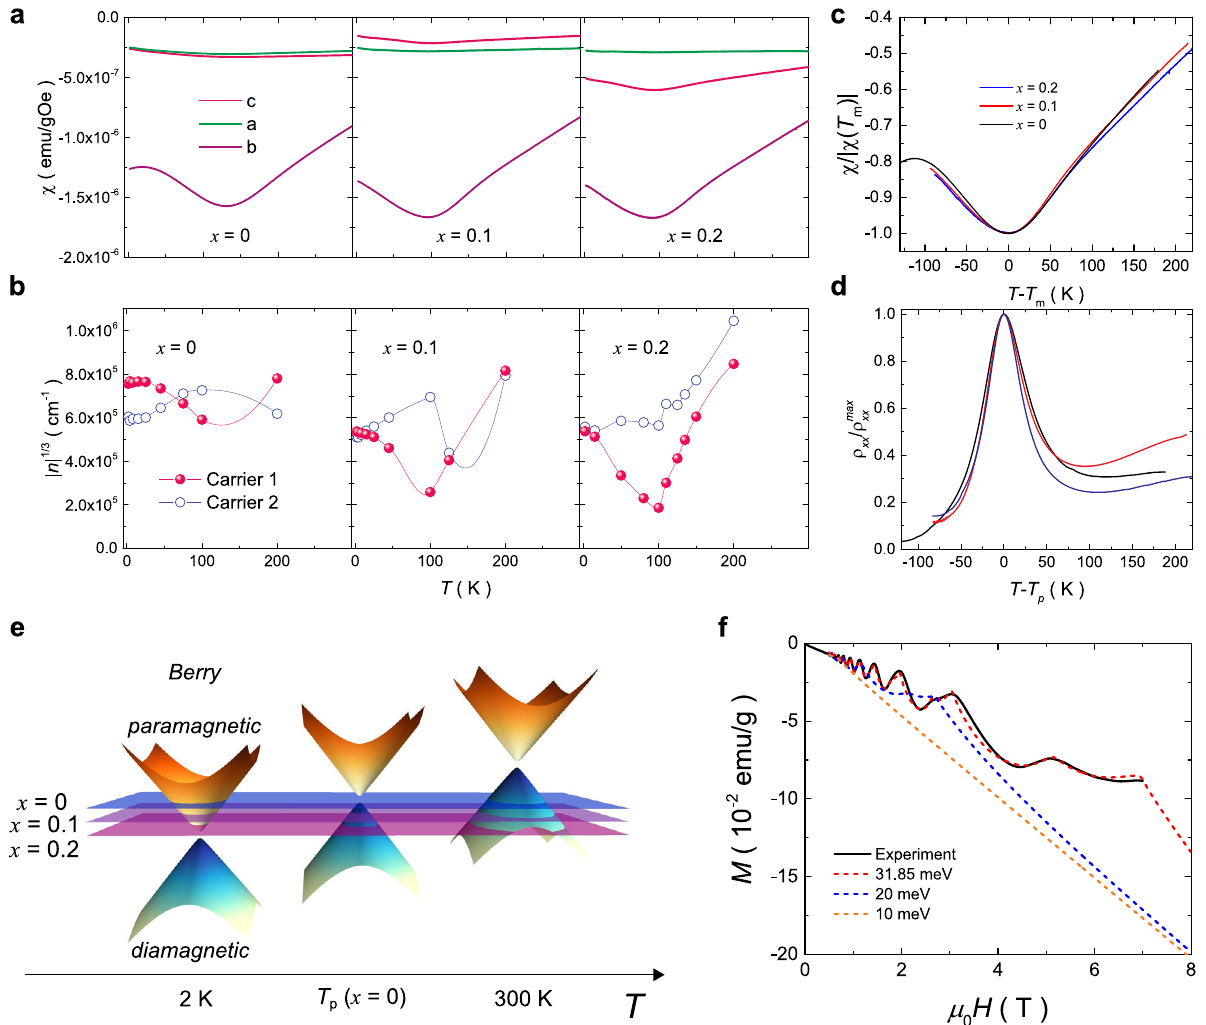
Fig. 5 Correlation between resistivity and susceptibility. a Temperature dependence of susceptibilities with 7 T of a magnetic fi eld along with a , b , and c axes. b Temperature dependence of j n j 1 = 3 of carriers 1 and 2. The values of n were extracted from the two-carrier analyses. The error bars obtained using the standard error of the two-carrier fi t to a power of 1/3 are smaller than the size of the data symbols. c Normalized susceptibility curves. The susceptibilities were divided by the maximum value and plotted as a function of the relative temperature, T − T m , where T m is the temperature at which the susceptibility shows its minimum. d Normalized resistivity curves. The resistivities were divided by the maximum value and plotted as a function of the relative temperature, T − T p , where T p is the temperature at which the resistivity shows its peak. e Schematic picture for magnetic susceptibility and band shift depending on temperature for three samples. The planes show the Fermi energy of each sample at 2 K. f Simulated magnetization curves of x = 0 at 2 K for various Fermi energies. The solid black line denotes the experimental data, and the dashed lines represent simulated